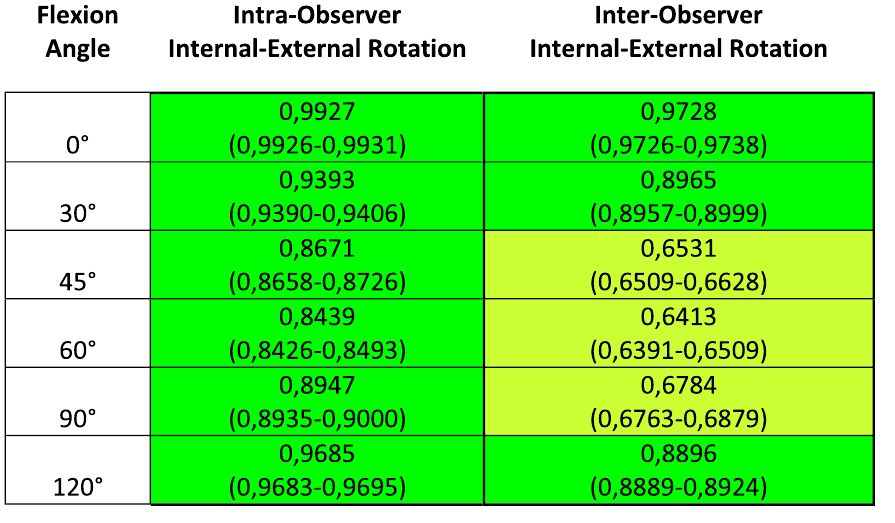
Table 2 ICC results for Internal-External Rotation measurements and relative Confidence Interval; highlighted in green, the ICC